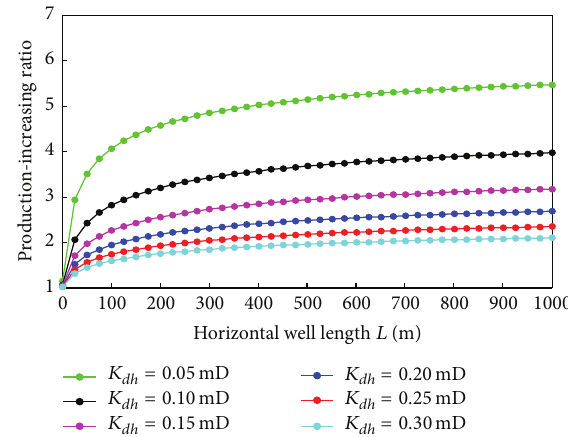
Figure 10: Effect of DZ’s permeability ( 𝐾 𝑑ℎ ) on production- increasing ratio ( 𝐿 = 1000 m, 𝑟 𝑤 = 0.1 m, 𝜀 = 0.00016 m, 𝛾 𝑔 = 0.56 , = 0.023 mPa ⋅ s, 𝑍 = 0.9 , 𝑇 = 366 K, ℎ = 10 m, 𝑝 𝜇 𝑔 = 0.6 mD, 𝐾 = 0.1 mD, 𝐾 𝐾 ℎ V = 0.2 m, 𝑎 = 1.2 m, and 𝑎 𝑑 V . min V . max